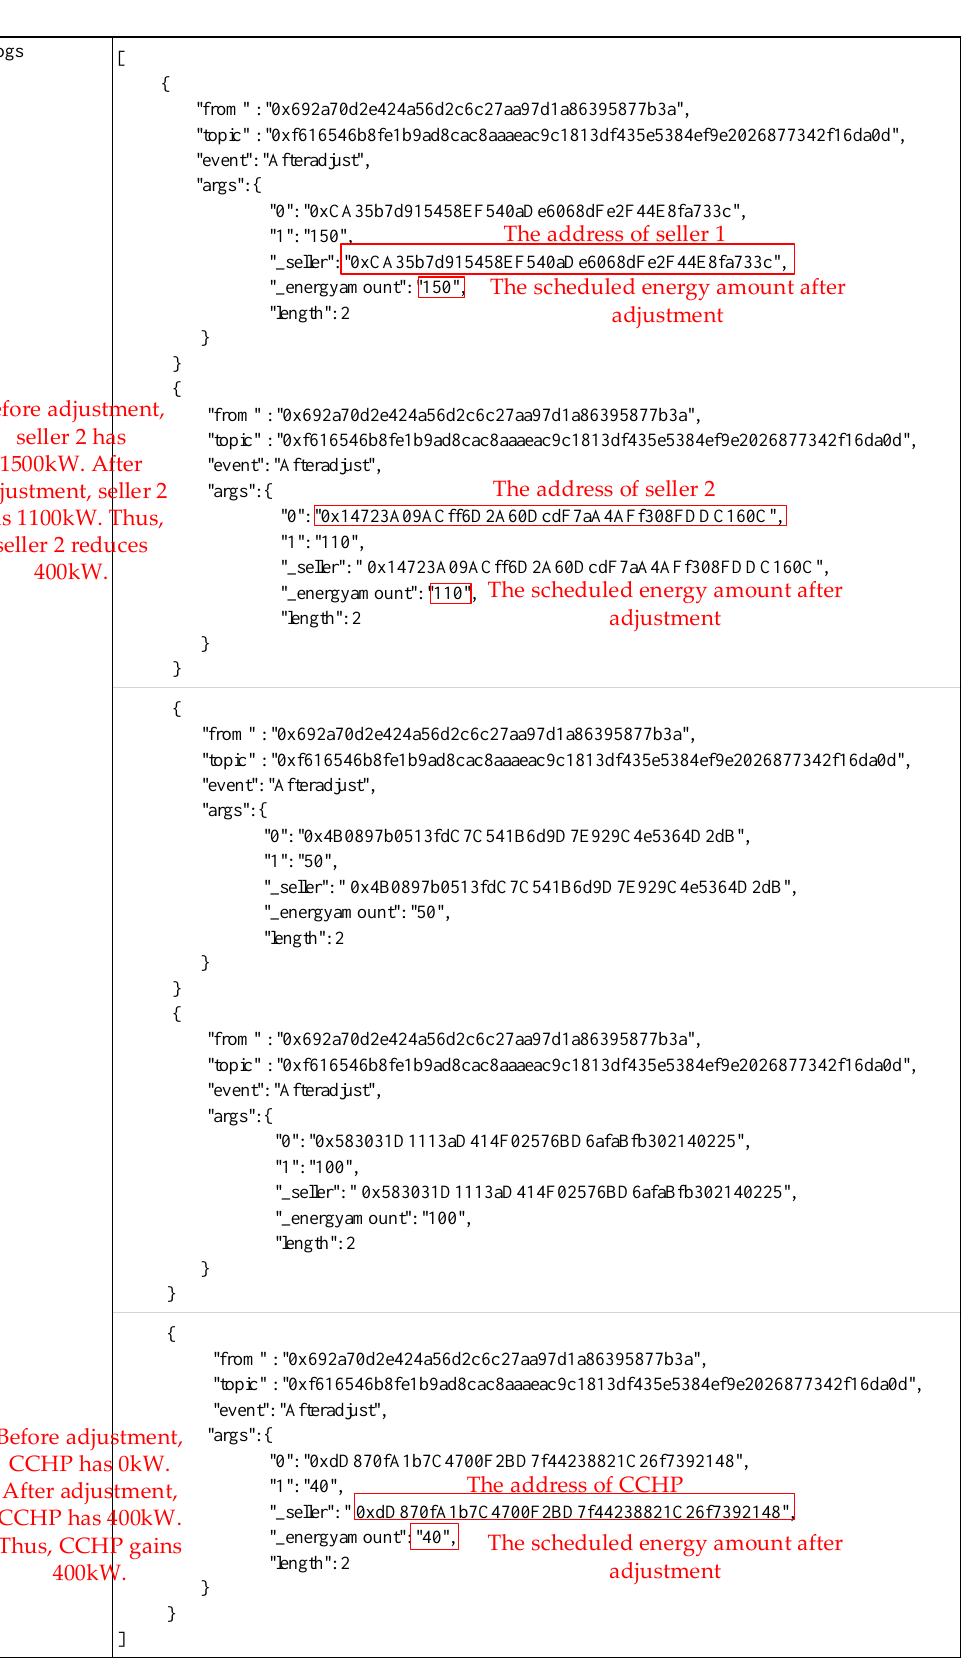
Figure 8. Record of the sellers’ scheduled amount after adjustment .